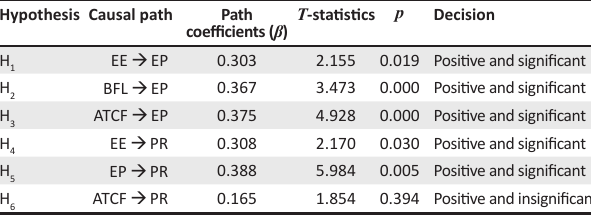
Source : Calculated from survey results. Arrows signify the relationships between each construct to indicate the proposed hypothesis.